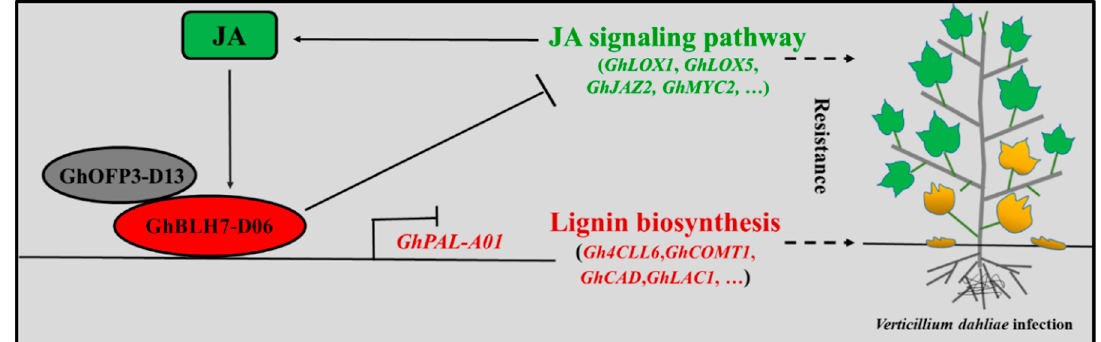
Figure 7. A schematic model of BEL1-Like protein GhBLH7-D06 participate in the negative regulation of cotton Verticillium wilt